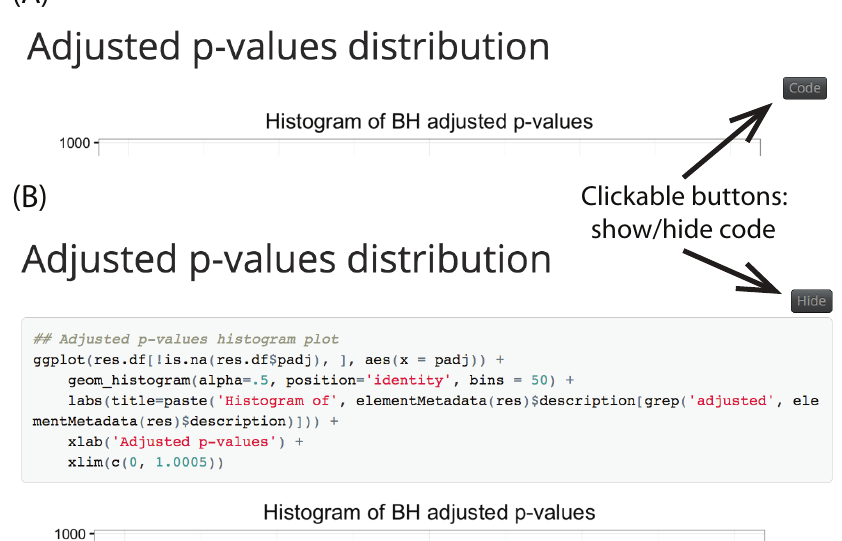
Figure 2. Interactively display the code for each table/figure in the report. ( AB ) View by default and ( B ) after clicking on the “code” toggle for a section in the report and the HTML reports include a toggle to hide/show all the R